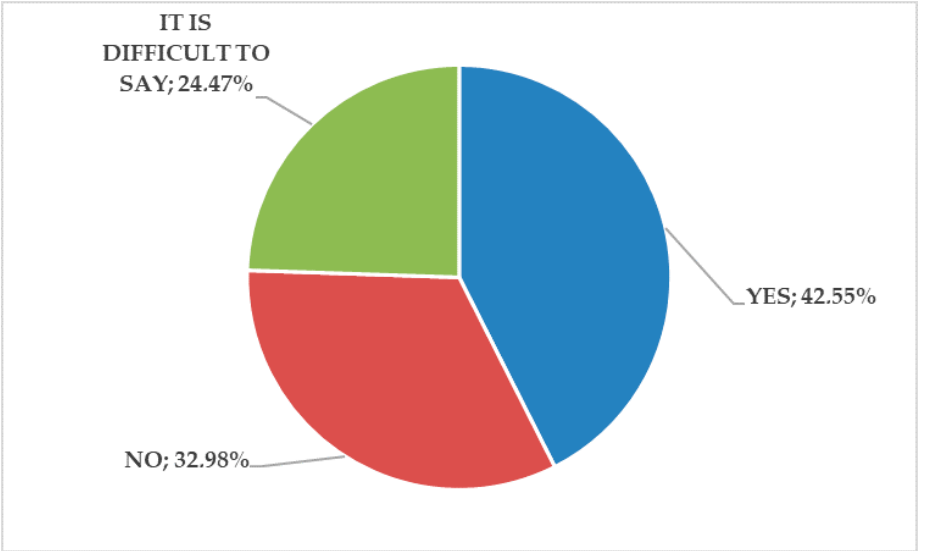
Figure 7. Distribution of responses to the question about initiating external contacts by institute authorities. Source: own elaboration based on the results of questionnaire surveys.